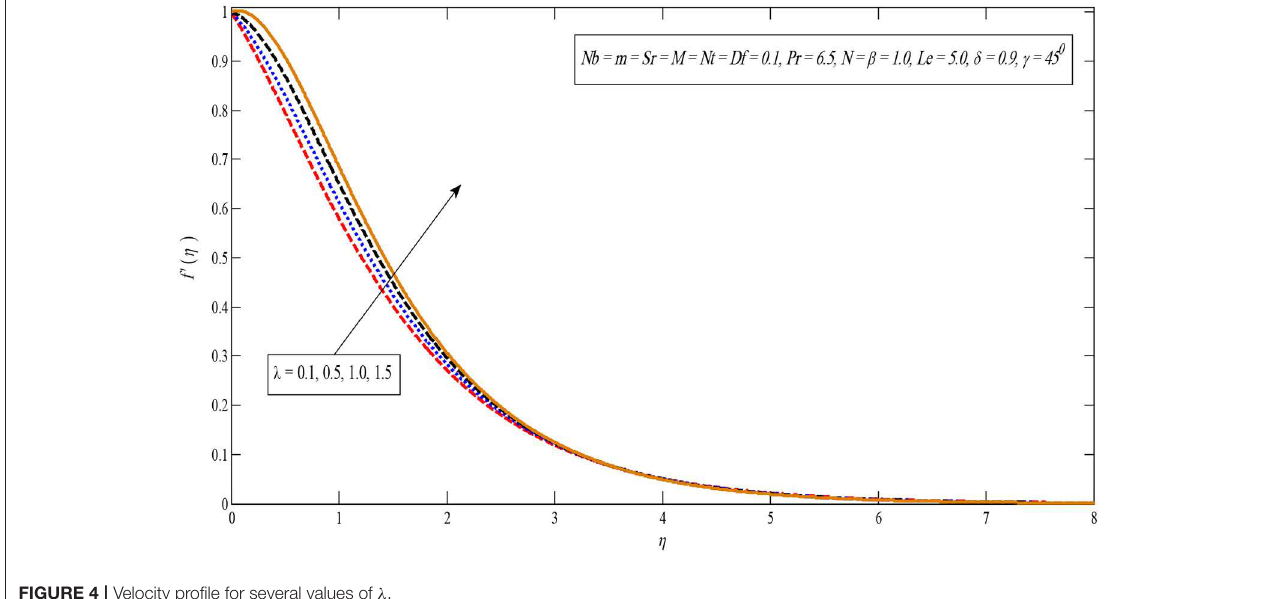
FIGURE 4 | Velocity profile for several values of λ .